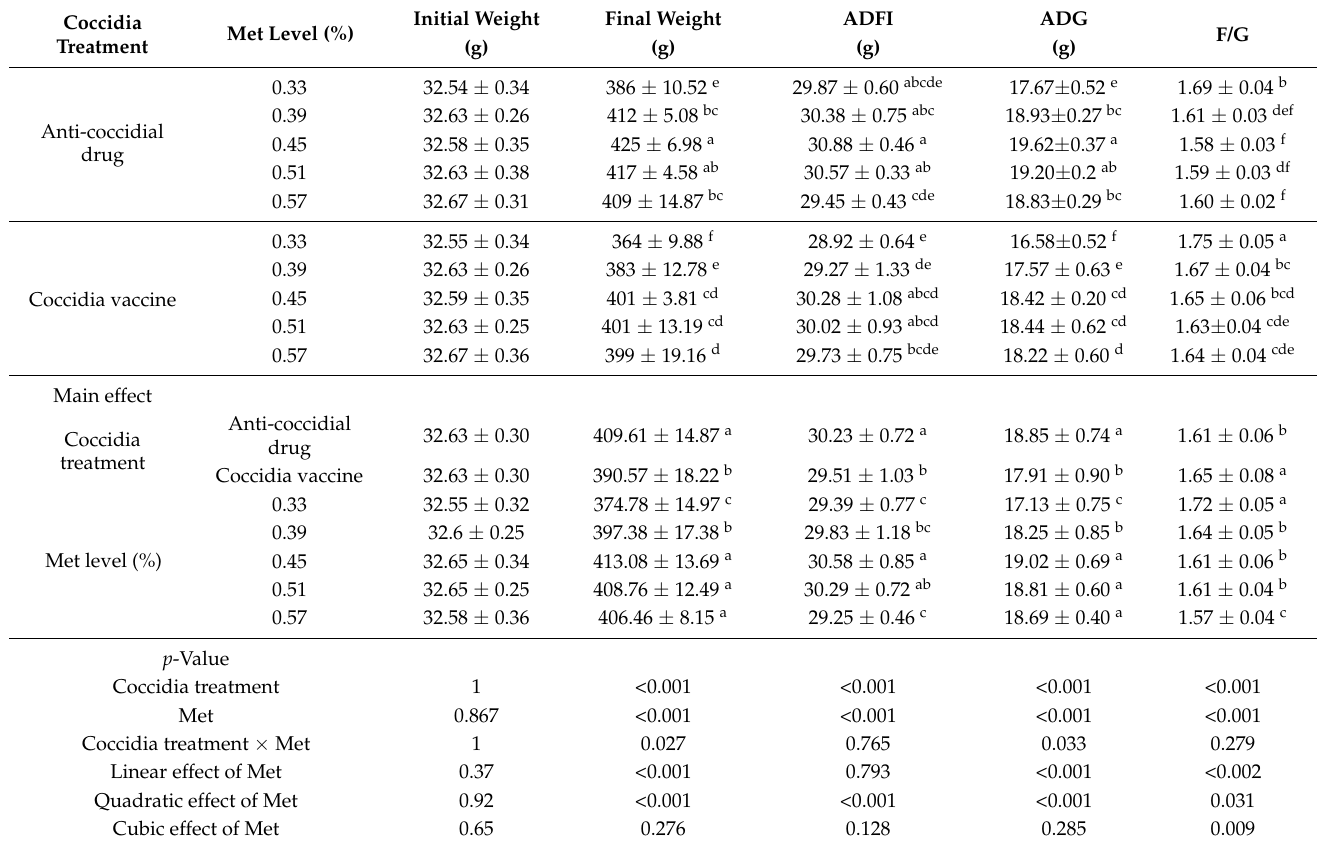
Table 3. Effect of different treatments on the growth performance of 1~21 d partridge shank